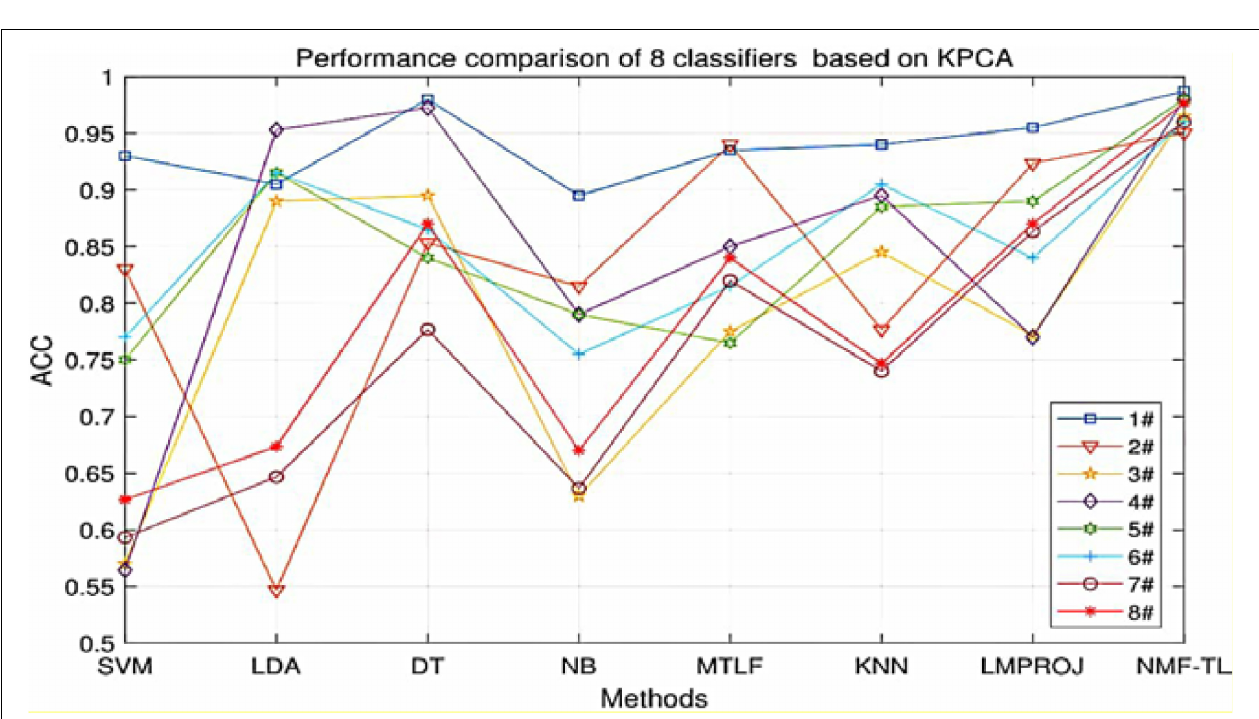
FIGURE 6 | Classification accuracy comparison of 8 classifiers on datasets based on KPCA feature extraction.